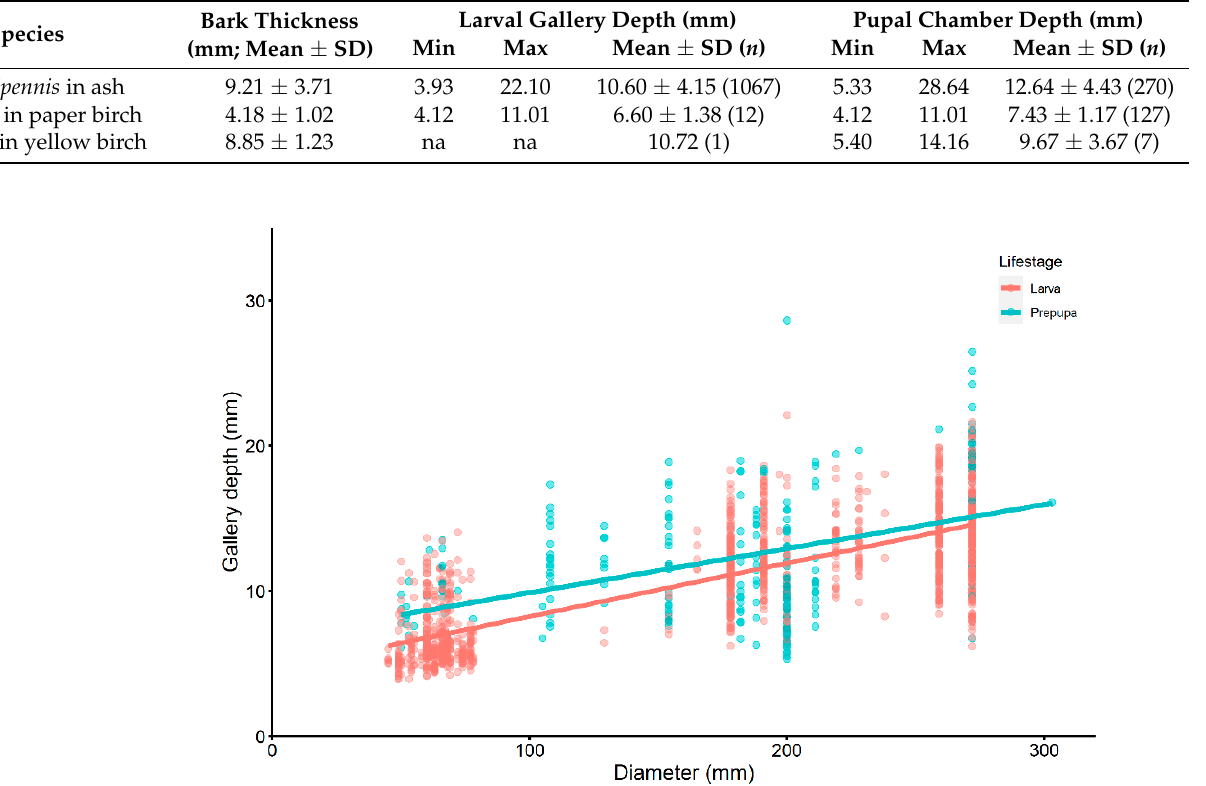
Table 5. Mean gallery depths (including bark) and bark thickness of A. planipennis and A. anxius immatures measured using CT-scan imagery.